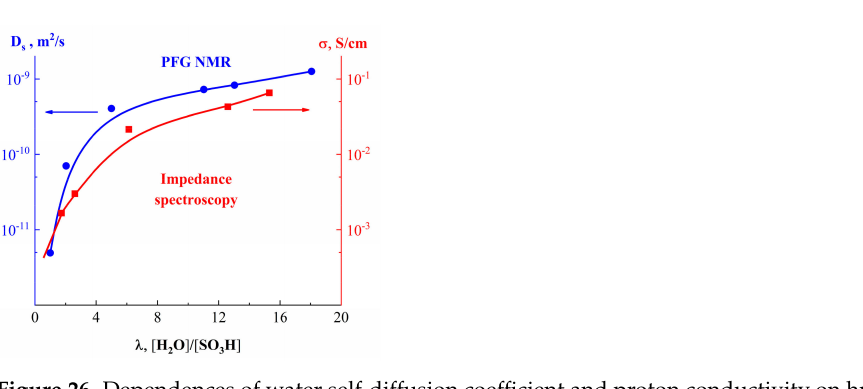
Figure 26. Dependences of water self-diffusion coefficient and proton conductivity on humidity ( λ ), where λ is water molecule amount per sulfonate group in acid form of MF-4SC membrane